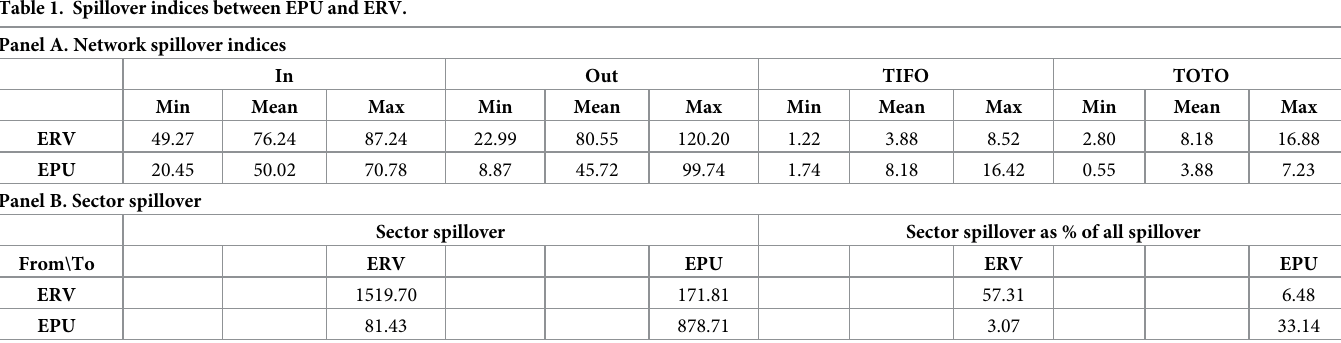
Table 1. Spillover indices between EPU and ERV. Panel A. Network spillover indices